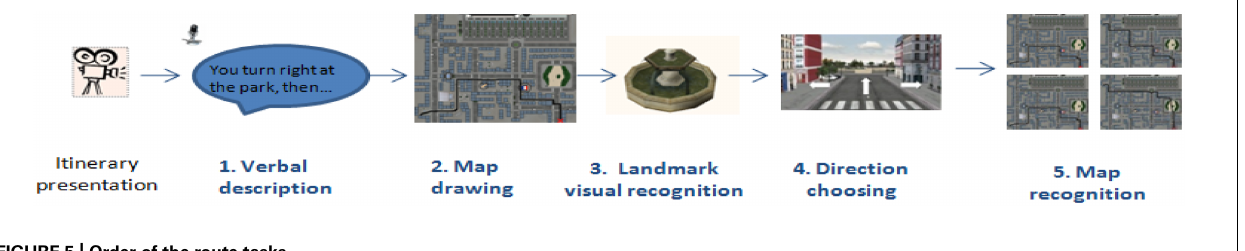
FIGURE 5 | Order of the route